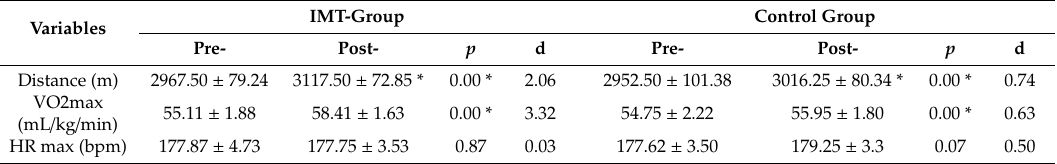
Table 4. Comparison of aerobic tolerance assessed by Cooper test, estimated of VO 2 max, and maximum